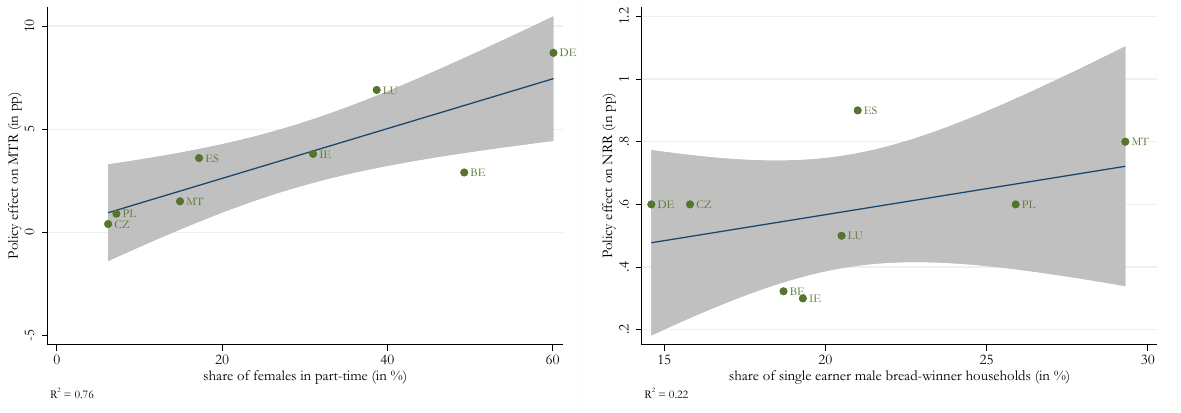
Figure 4. Correlation between policy effects (PE) and labour market outcomes: ( left panel ) PE on METR vs. share of women in part-time ( right panel ) PE on NRR vs. share of male single-earner households. Notes: EUROMOD estimations for 2019 based on EU-SILC